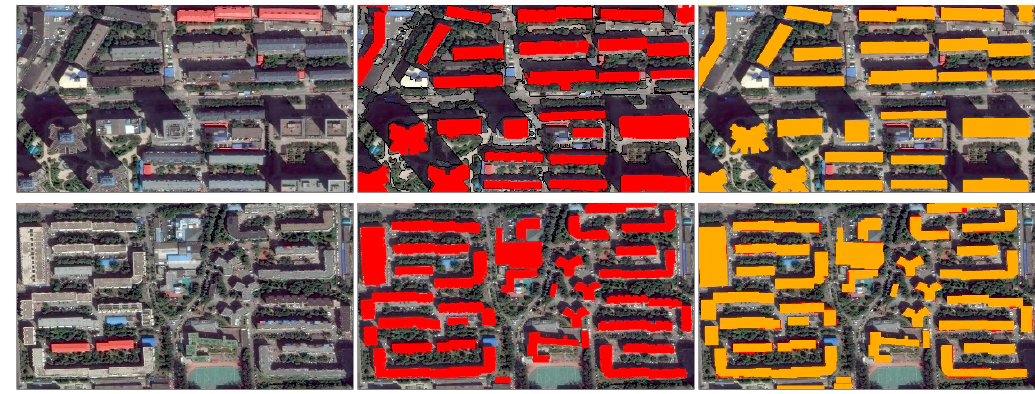
Figure 4. Extracted building rooftops.